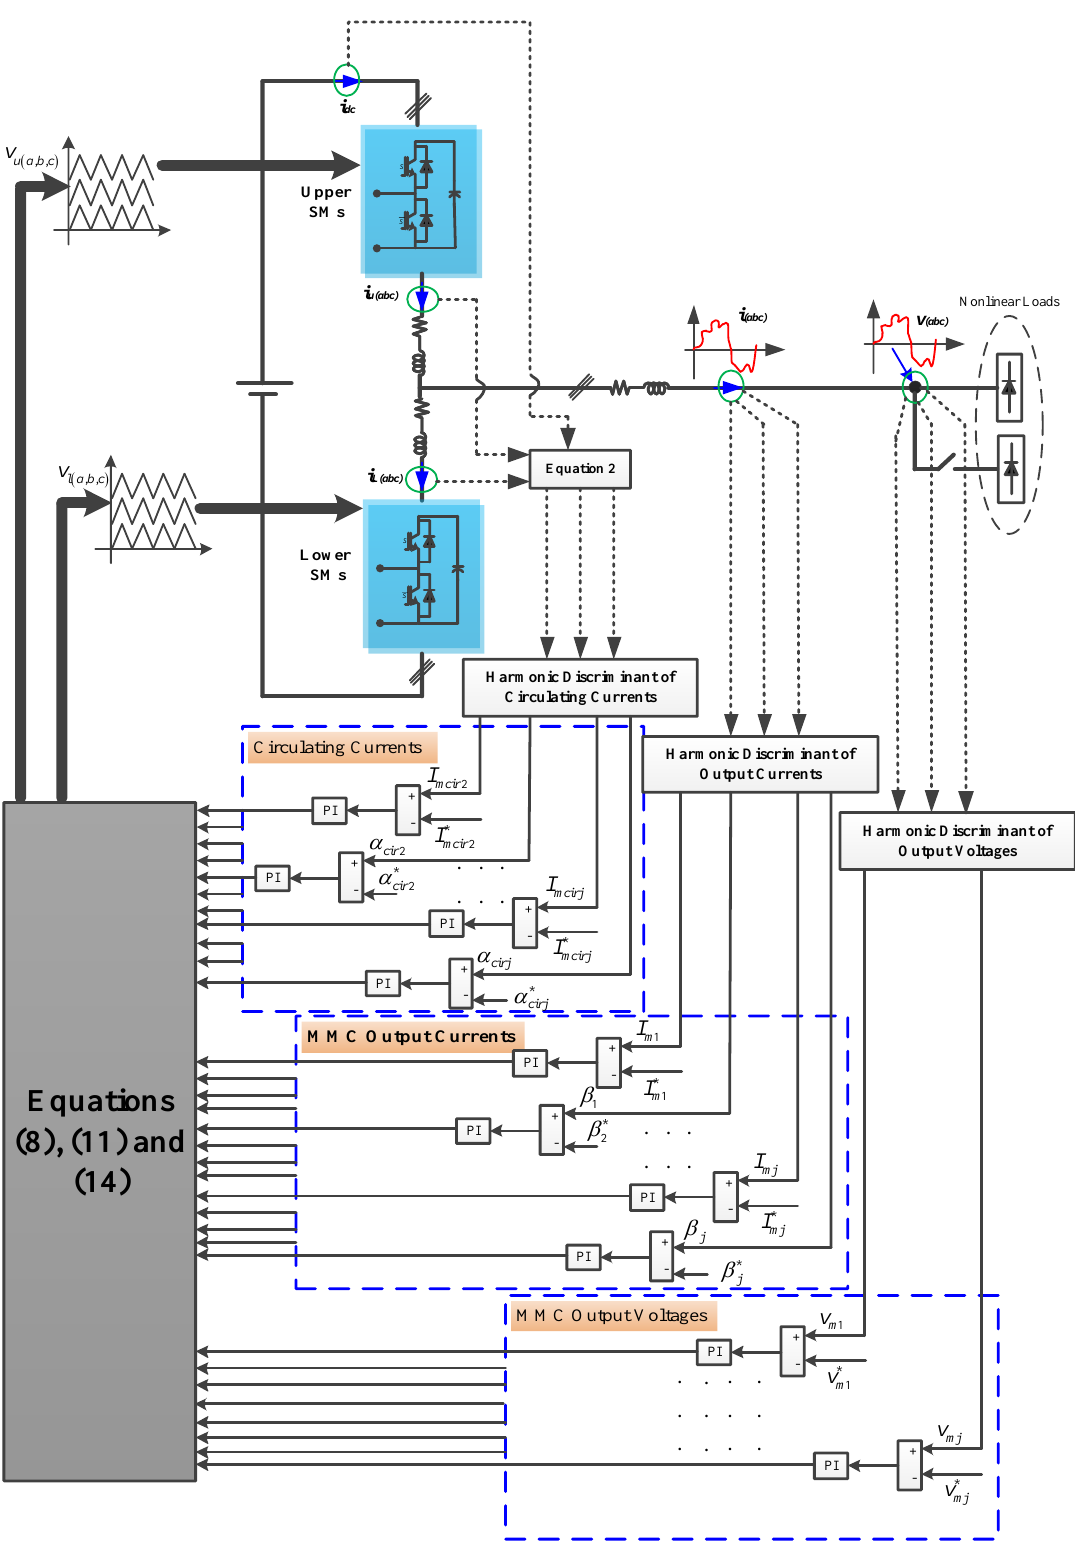
Figure 10. Overall structure of the proposed control strategies.